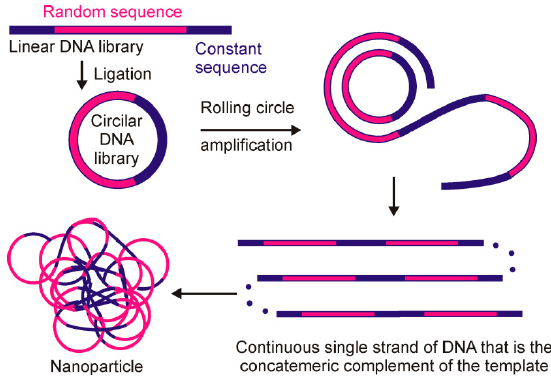
Figure 2. A general scheme of RCA-based DeNAno method for obtaining cell-specific DNA superstructures [71].